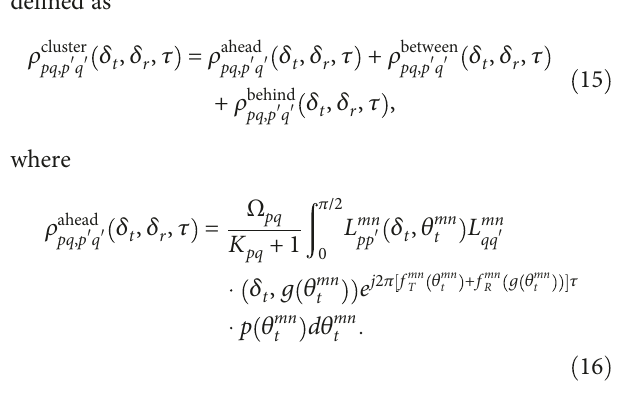
and v denote the speed of Tx and Rx, respectively; d t r